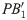
Characterization of clonal expansion and contraction of CD8+ T cells (%CD11a T cells) after immunization with irradiated sporozoites (irrSpz).A) Characterization of clonal expansion and contraction elicited by a single inoculation of 10.000 irrSpz and B) 100.000 irrSpz. C) Comparison of T cell memory formation by protocols P, PB1 and PB2. P: Single inoculation of 50.000 irrSpz; PB1 and PB2: prime with 10.000 irrSpz + boost with 40.000 irrSpz three and seven days after prime respectively. D) Formation of memory T cells by protocols P′, PB1′ and PB2′. P′: single inoculation of 140.000 irrSpz; PB1′ and PB2′: prime with 100.000 irrSpz and boost with 40.000 irrSpz three and seven days after prime respectively. (n = 3 in A, B and D. n = 5 in C, n being the number of mice used in each experiment). The number of memory T cells is expressed as the percentage of resident memory T cells in the total population of CD8+ T cells. Resident memory T cells where measured 21 days after boosting. Experimental data shown in this picture are provided in Tables A-D in S1 File.